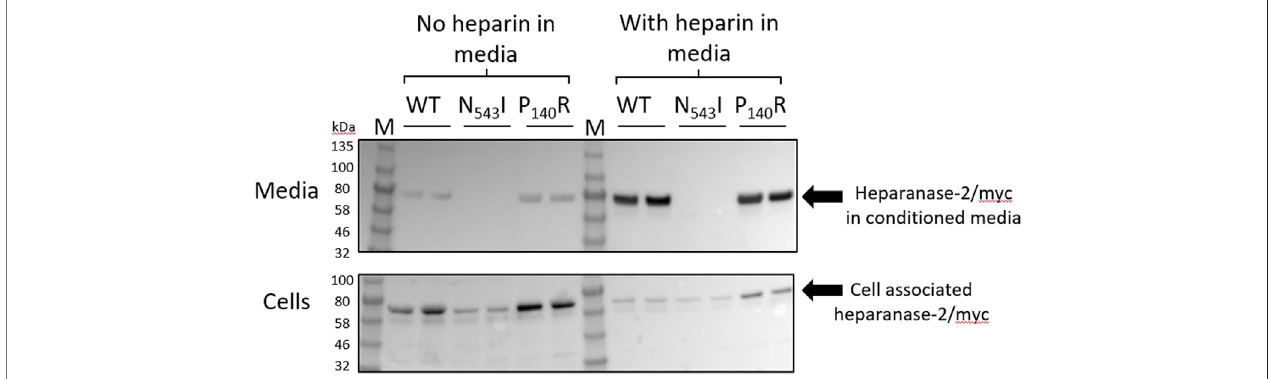
FIGURE 5 | Expression of wild type and missense variant proteins in HEK293 cells. Non quantitative western blot analyses using anti-myc antibody. HEK293 cells were transfected with pCDNA3:HPSE2cmyc wild-type ( WT ) or the myc-tagged the p.Asn543Ile variant (abbreviated to N543I in the annotated image) or the p.Pro140Arg variant (abbreviated to P140R in the annotated image) variant. Samples, with two replicates shown for each condition, were studied at both 3 days after transfection ( No heparin in media ) and also 24 h later after the addition of heparin to the media ( With heparin in media ). The upper blot is of the conditioned media ( Heparanase-2/mycinconditionmedia ) , whilethelowerblotisfromcelllysates( Cellassociatedheparanse-2/myc ).Notethatallthreeproteinsweredetectedincells,and that the wild-type and the p.Pro140Arg variant were detected in the conditioned media. The lack of the p.Asn543Ile variant in conditioned media was documented both before and after adding heparin to the media; this molecule is known to bind native heparanase-2 (McKenzie, 2020). In blots of both the wild-type and the p.Pro140Arg variant, the addition of heparin to the media appeared to increase the intensities of the detected protein bands in the supernatant compared with the intensities of the bands that were